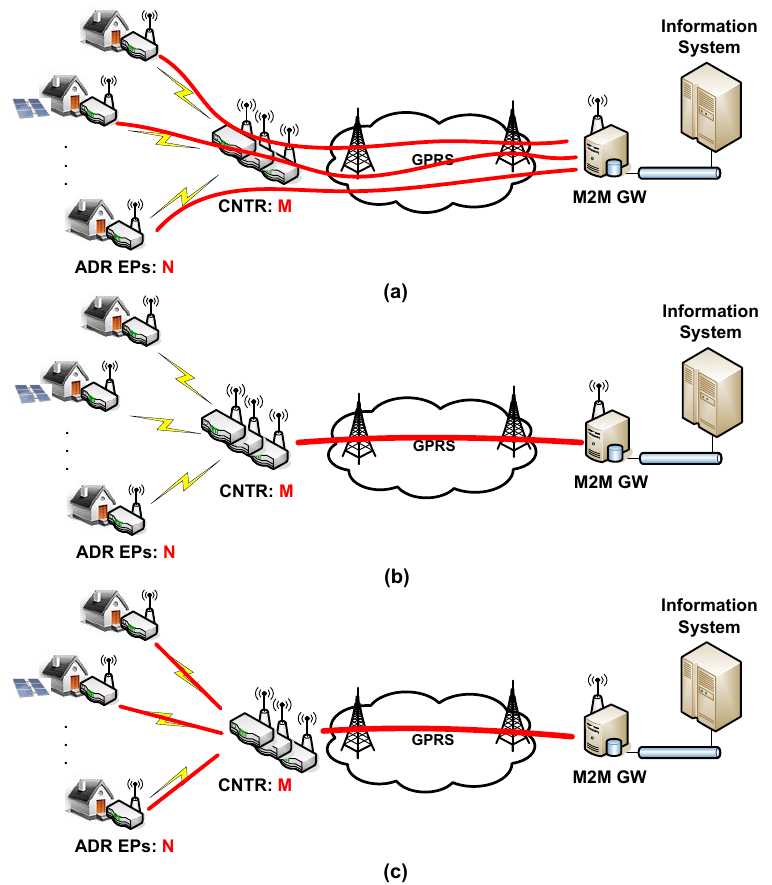
Figure 10. ( a ) NxM direct secure tunnels from the ADR EPs to the M2M GW; ( b ) M secure tunnels from the CNTRs to the M2M GW; ( c ) NxM secure tunnels from the